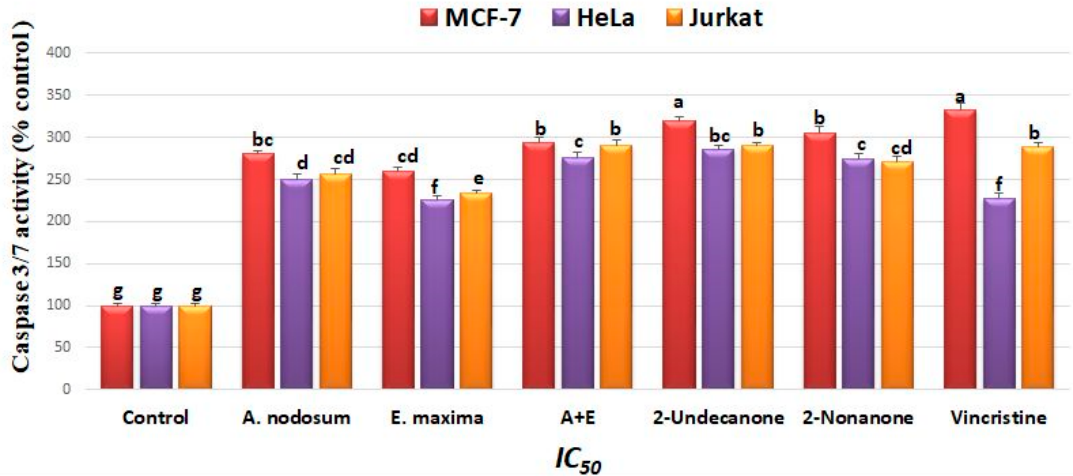
Figure 5. Effect of seaweed treatments, 2-undecanone, and 2-nonanone (IC50) on the activity of caspase 3/7. The activity was expressed as a percentage (%) of untreated cells. Different letter on columns indicate significant differences within each treatment at p ≥ 0.05. A + E: A. nodosum + E. maxima.